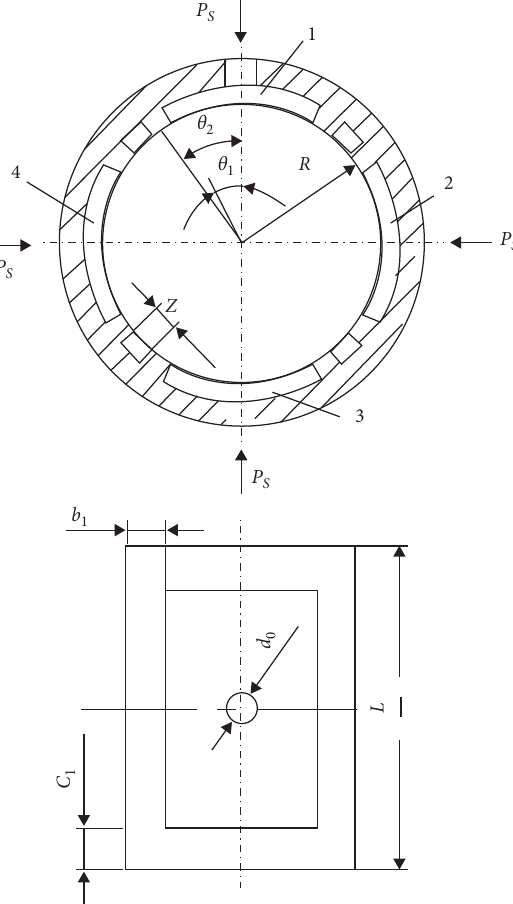
Figure 2: Structure of radial bearing.